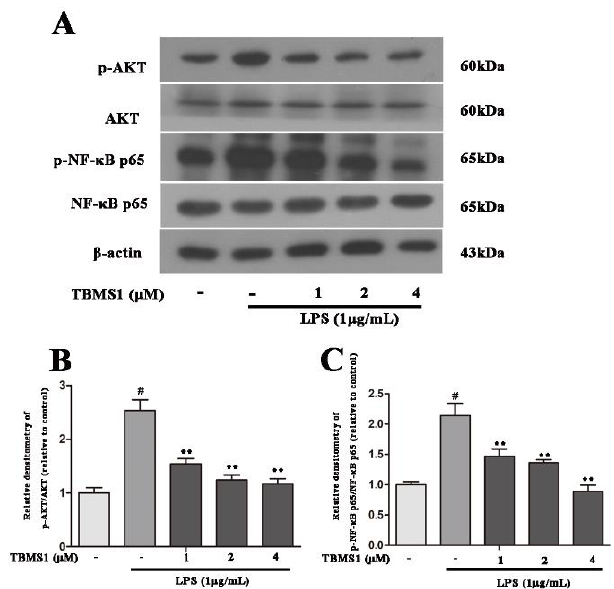
Figure 7. TBMS1 inhibits the phosphorylation of AKT and NF- κ B p65 in LPS-exposed BV-2 cells. The BV-2 cells were pretreated with TBMS1 (1, 2 and 4 µ M) for 1 h, then incubated with LPS (1 µ g/mL) for 1 h. ( A ) The protein levels of AKT, NF- κ B p65 and their phosphorylated forms were tested by western blotting. The phosphorylation of AKT ( B ) and NF- κ B p65 ( C ) was analyzed relative to β -actin. The results are shown as mean ± SD of three independent experiments. # p < 0.01 versus control condition. ** p < 0.01 versus the TBMS1-untreated LPS-exposed cells, and statistical significance was determined by ANOVA.